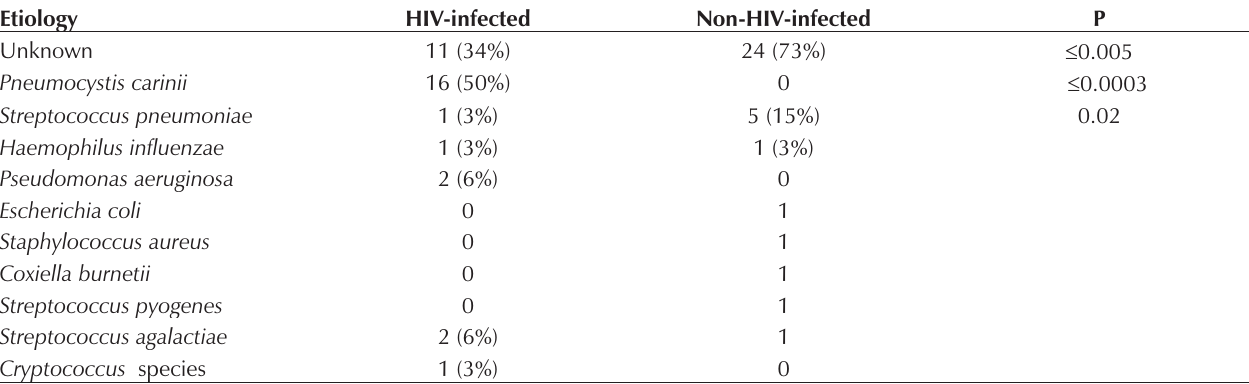
Etiological diagnoses of community-acquired pneumonia in HIV-infected patients and in non-HIV-infected patients Etiology HIV-infected